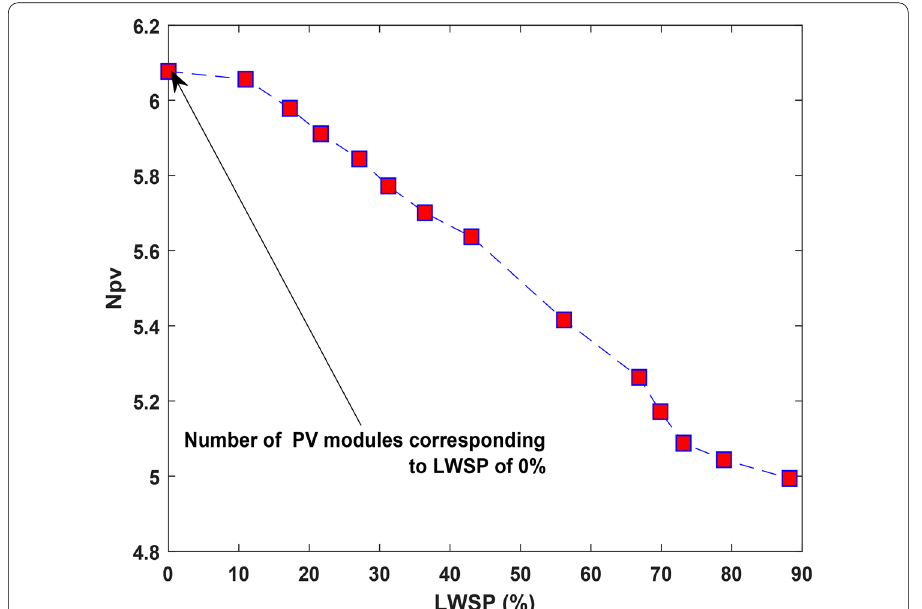
Fig. 7 Variation in number of PV modules on Pareto front